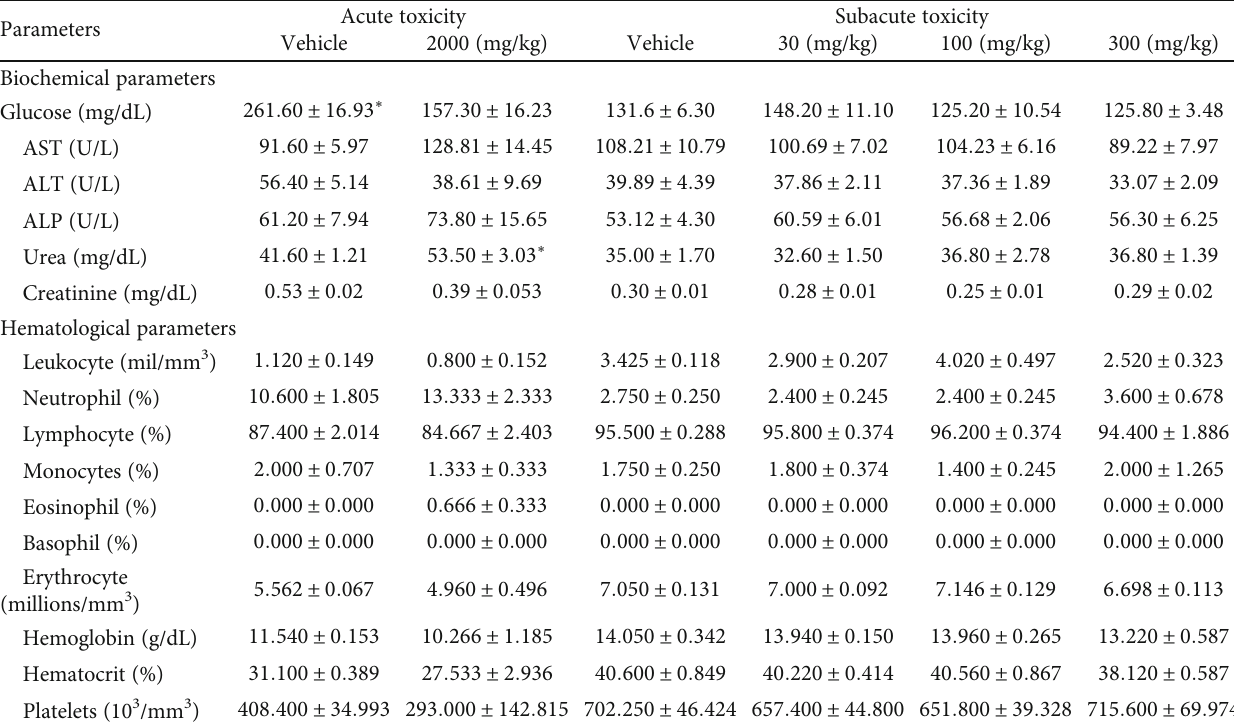
Table 3: Biochemical markers and hematological parameters following the acute administration of the S. diploconos fruit extract (values expressed as mean ± SEM ( n = 5 )). ∗ p < 0 : 05 vs. the vehicle group.